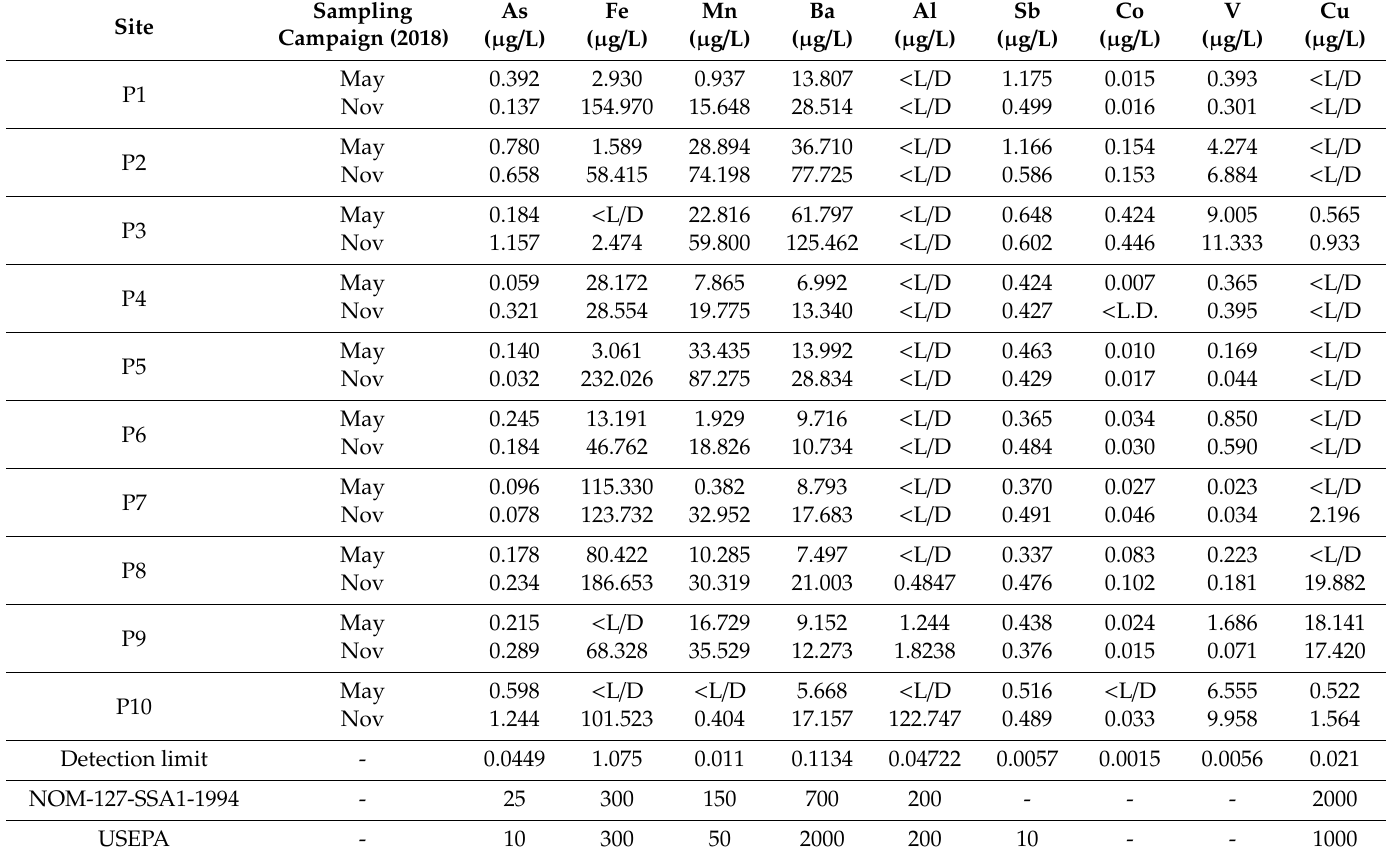
Table 9. Concentrations of trace elements in the water samples from the 10 sites (g / L): arsenic (As), iron (Fe), manganese (Mn), barium (Ba), aluminum (Al), antimony (Sb), cobalt (Co), vanadium (V), and copper